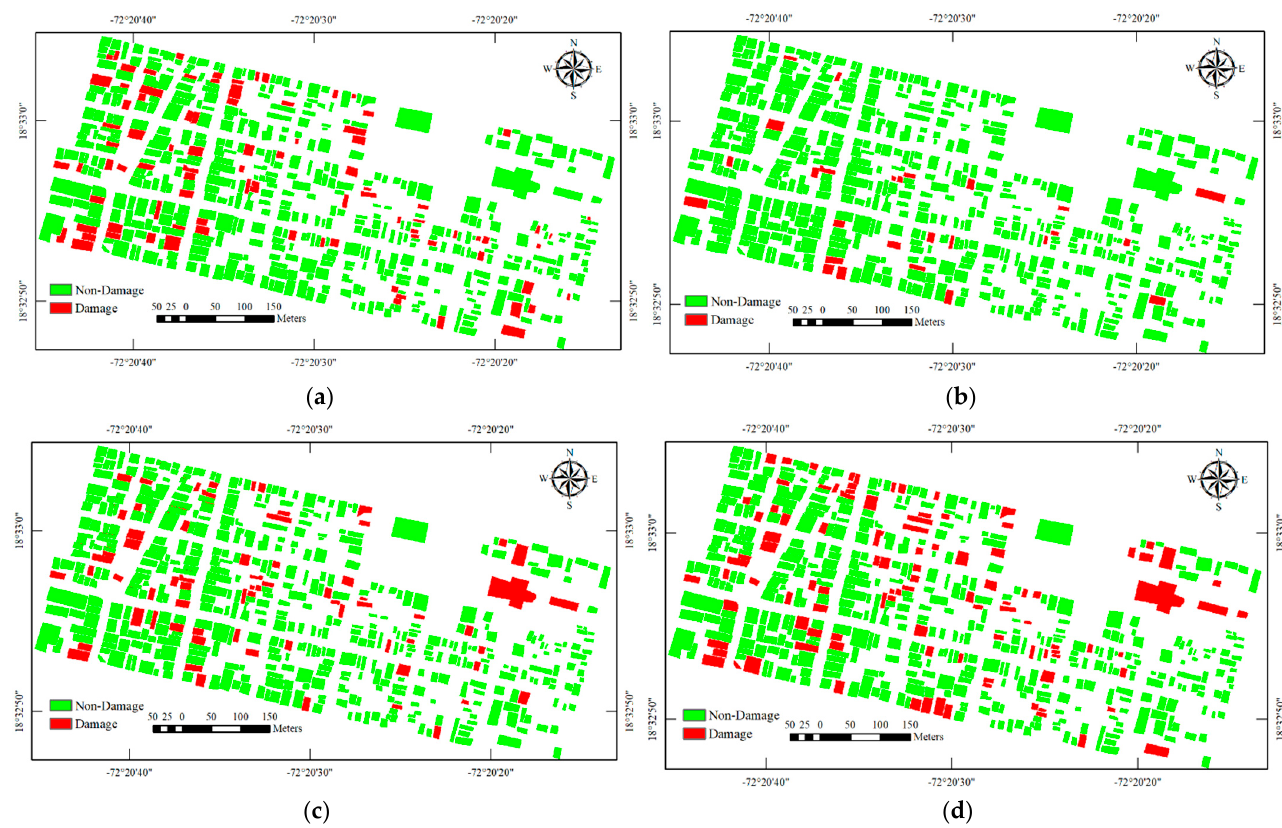
Figure 10. Results of building damage detection by proposed CNN, ( a ) Lidar, ( b ) optical, ( c ) fusion of Lidar and optical, and ( d ) ground truth.